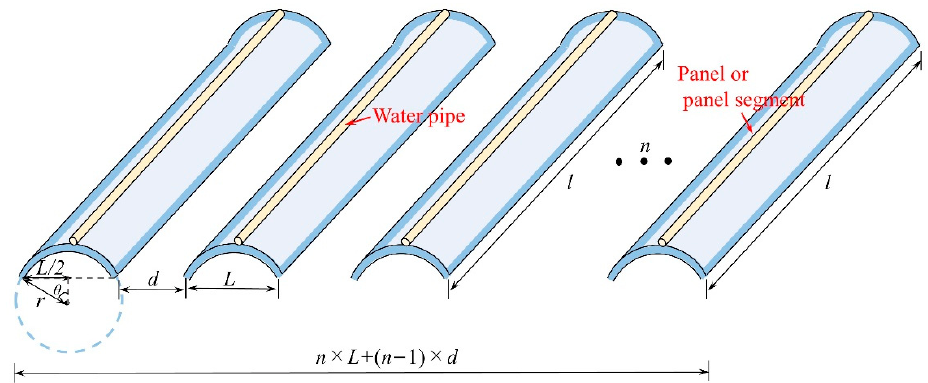
width ( L ), void distance ( d ), and panel coverage area ( A c ).